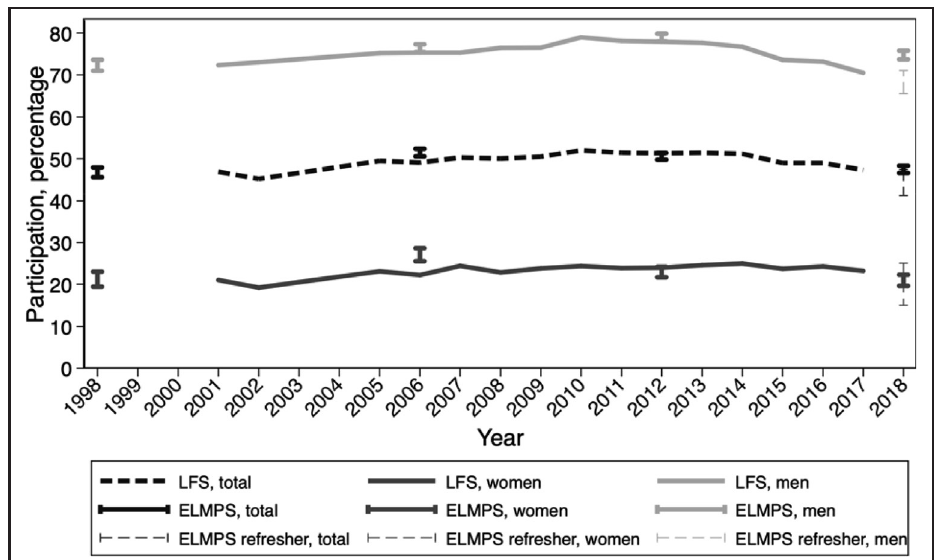
Labor force participation rate (percentage), by sex and data source, ages